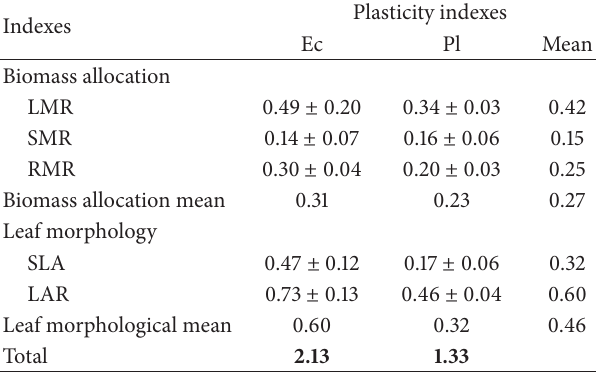
Table 3: Plasticity indexes for morphological parameters in seedlings of the three rain forest tree species under different light